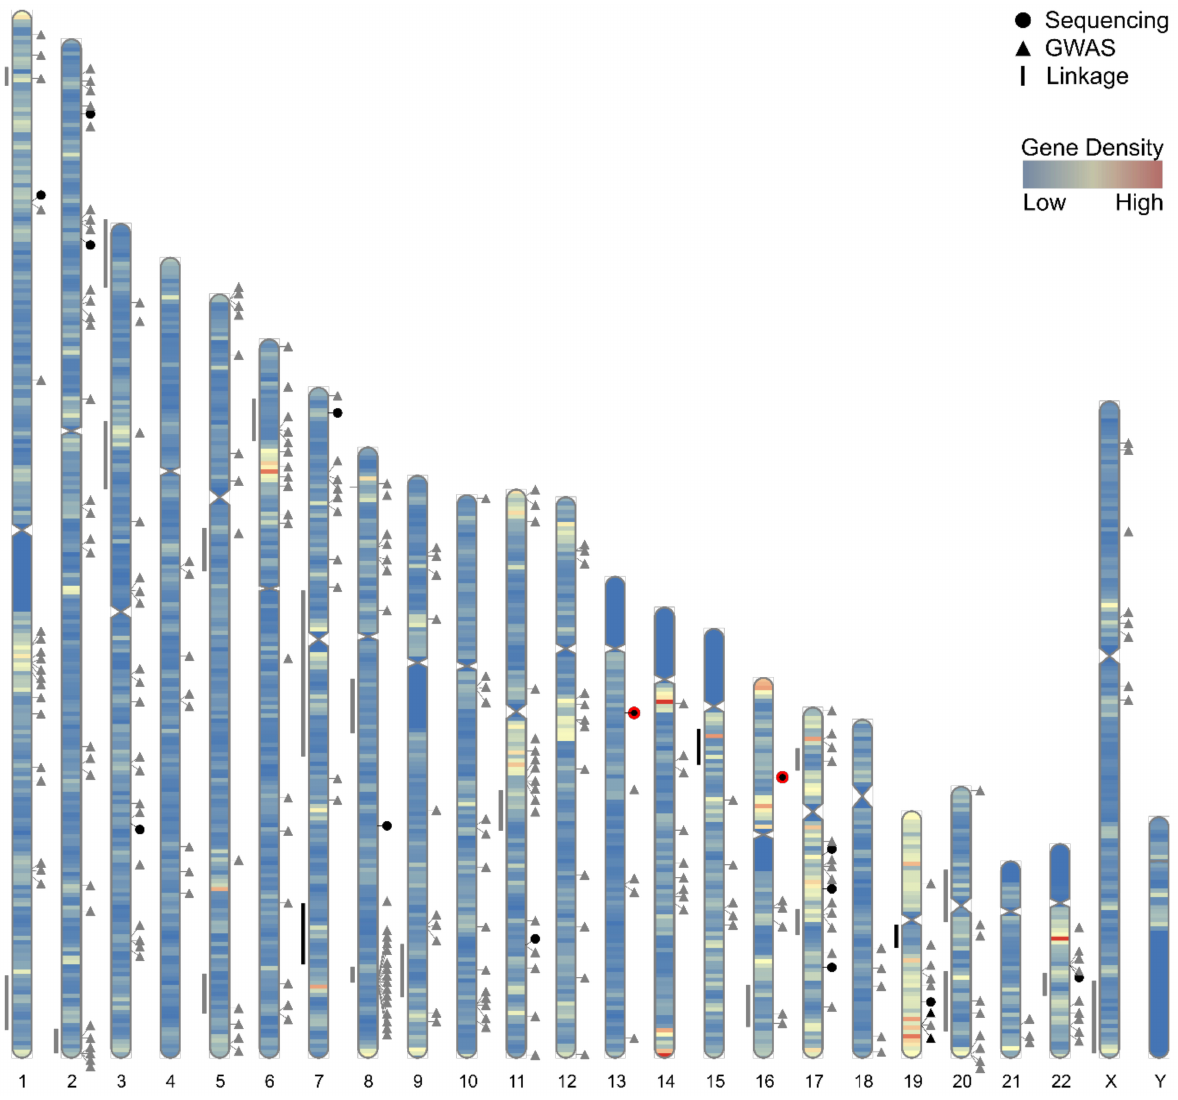
Figure 1. Karyogram depicting the approximate locations of candidate PrCa risk loci reported through linkage, GWAS and sequencing study approaches. To the right of the chromosome ideogram, triangle symbols indicate the position of 269 reported independent GWAS index variants [127] and circle symbols the locations of DNA repair genes reported as a potential candidate for risk in two or more PrCa sequencing studies (listed within Table 1). To the left of the chromosome ideogram, line symbols show the approximate intervals of linkage peaks according to representative markers for the region or cytogenetic band co-ordinates. Grey coloured symbols indicate no or limited evidence for association with risk of aggressive PrCa, the black colour denotes moderate or conflicting evidence for risk of aggressive disease and black symbols with a red border signify stronger evidence for a contribution towards poorer prognosis phenotypes. The karyogram is overlaid with a heat map depicting gene density across the human genome in 1 Mb windows and was generated using RIdeogram [128] and custom plotting